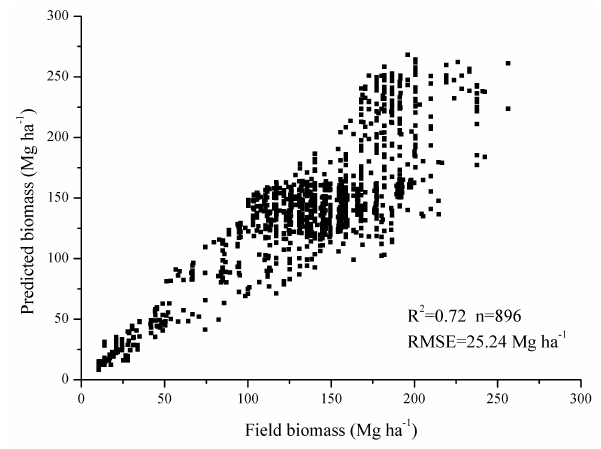
Figure 6. Comparison of forest inventory AGB with GLAS- and TM-derived AGB.